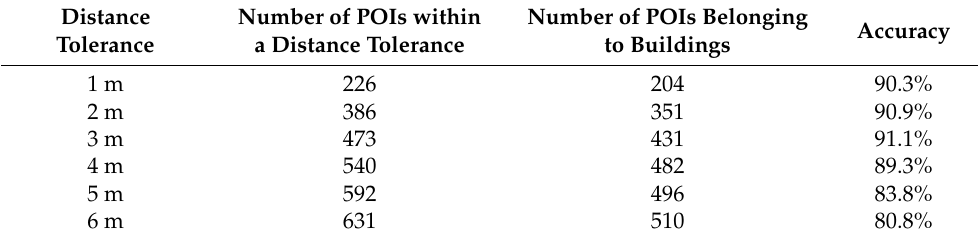
Table 3. The accuracy of outside POIs with a distance